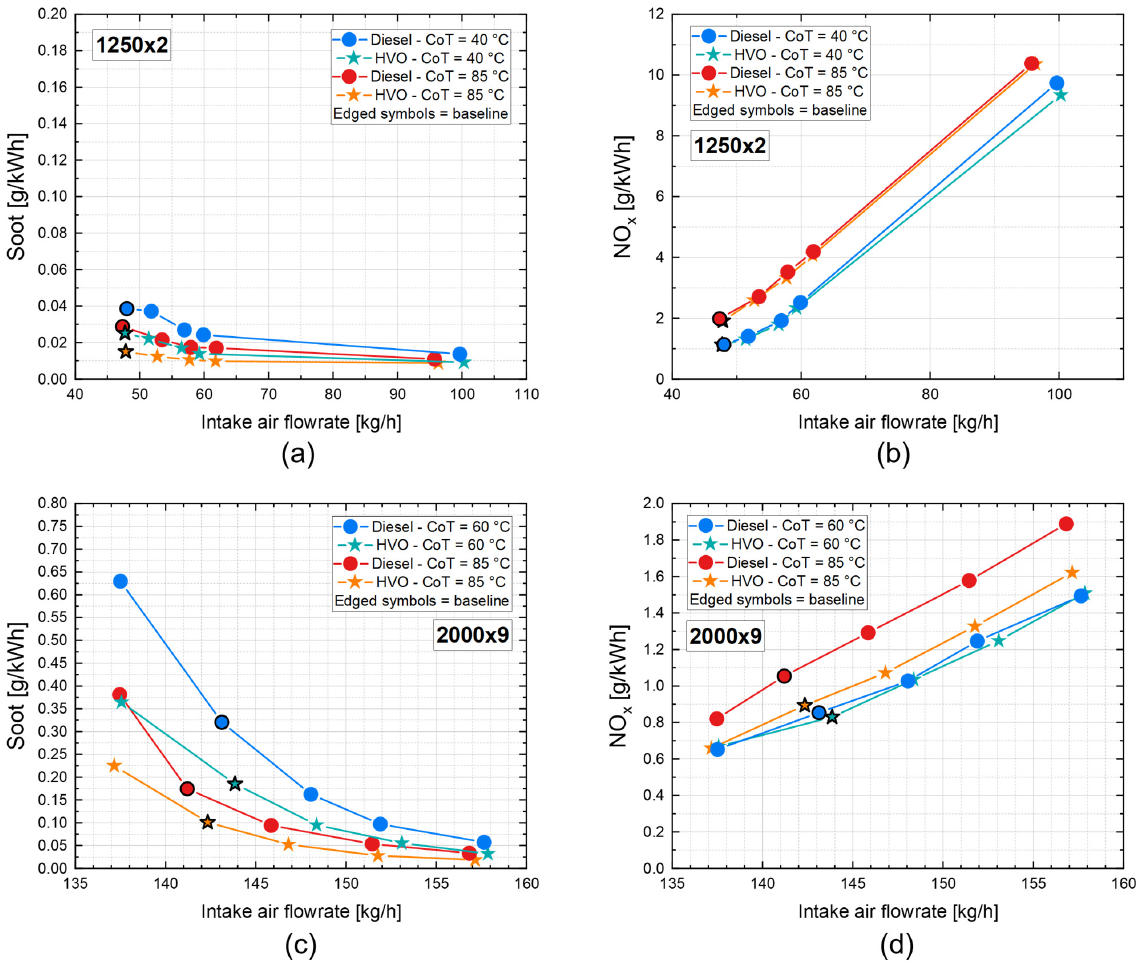
Figure 15. Soot and NOx emissions along intake air quantity sweep tests at 1250 × 2 ( a , b ) and 2000 × 9 ( c , d ). Comparison between diesel and HVO at high and low coolant temperatures. Warm colors represent high coolant temperatures, while cool colors represent low coolant temperatures. Circles represent diesel, while stars represent